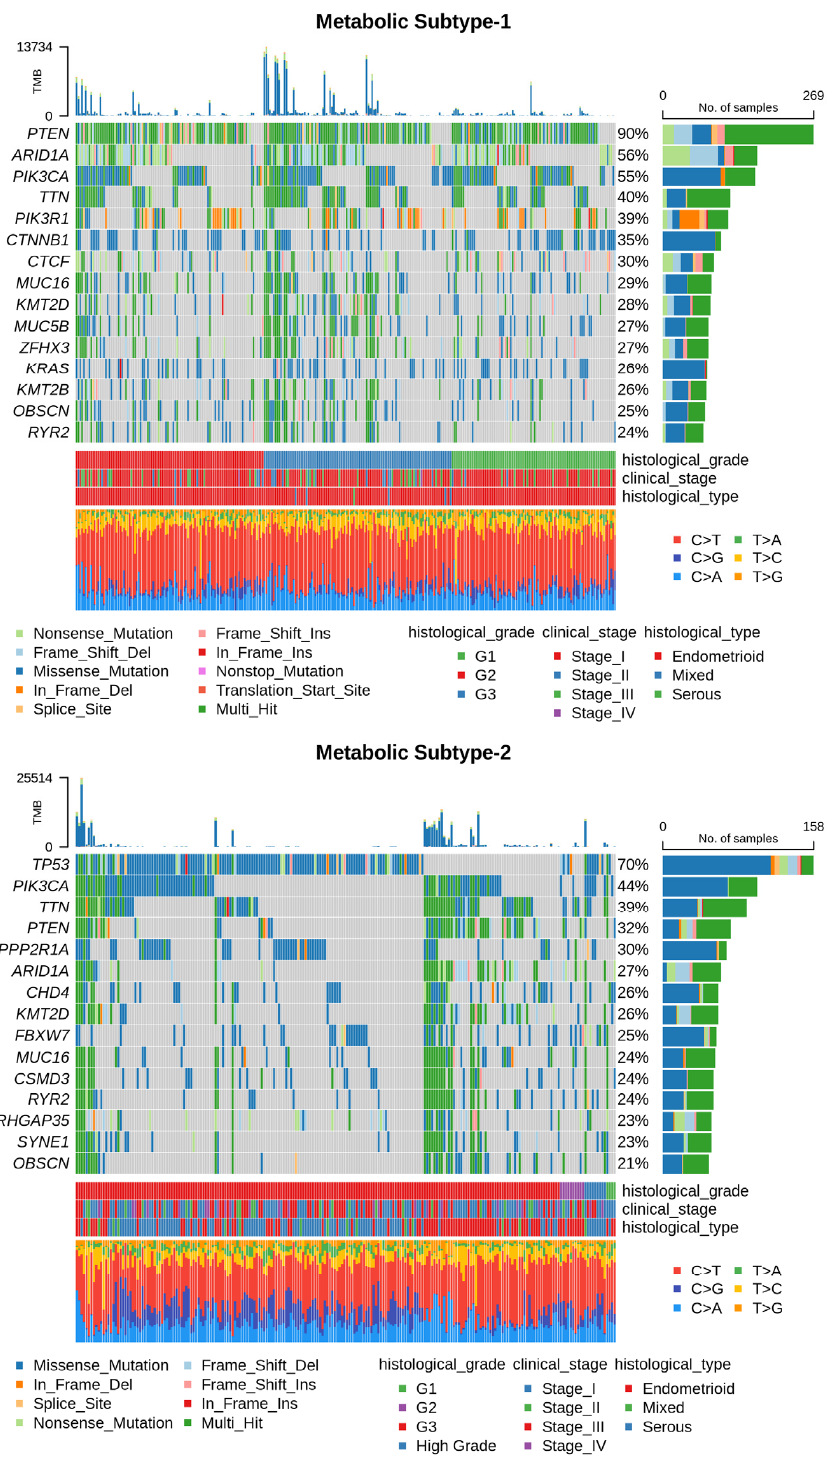
Figure 6. Oncoplot shows frequently mutated genes in metabolic subtype-1 and subtype-2 samples. Clinical subtypes and stages of samples are given along with various mutation types.